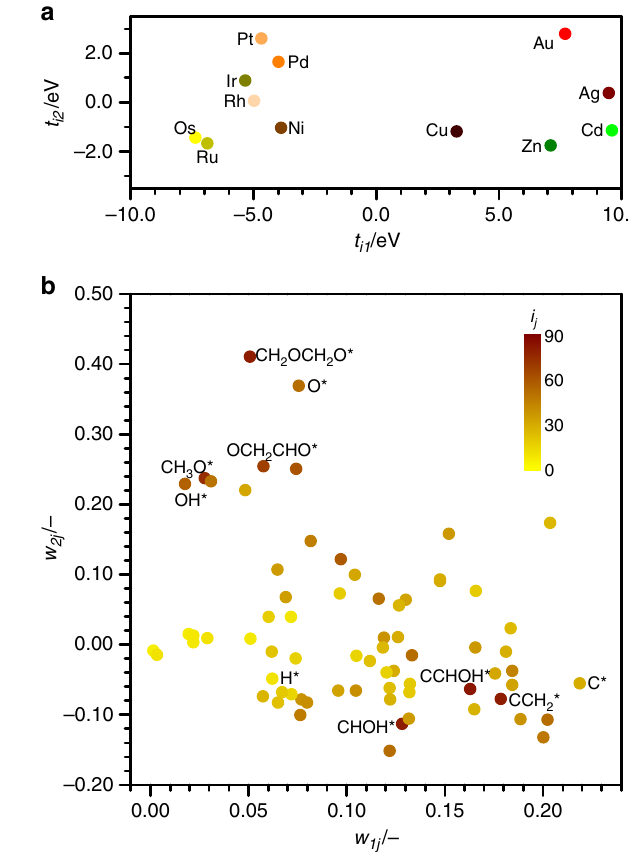
Fig. 1 Principal component analysis (PCA) and regression (PCR). The formation energy of species j on metal i is obtained from DFT and Eqs. (1)- (2). These energies are grouped in thermochemistry matrices, in red, and are approximated following PCA or PCR, in green. PCR was validated by leaving-one-metal-out of the data matrix (L1O). Variables associated with metals and species are shown in blue and orange, respectively. In black, variables associated with mathematical procedures. A data fl ow diagram, including the sizes of all matrices in this study, is shown in Supplementary Fig. 3